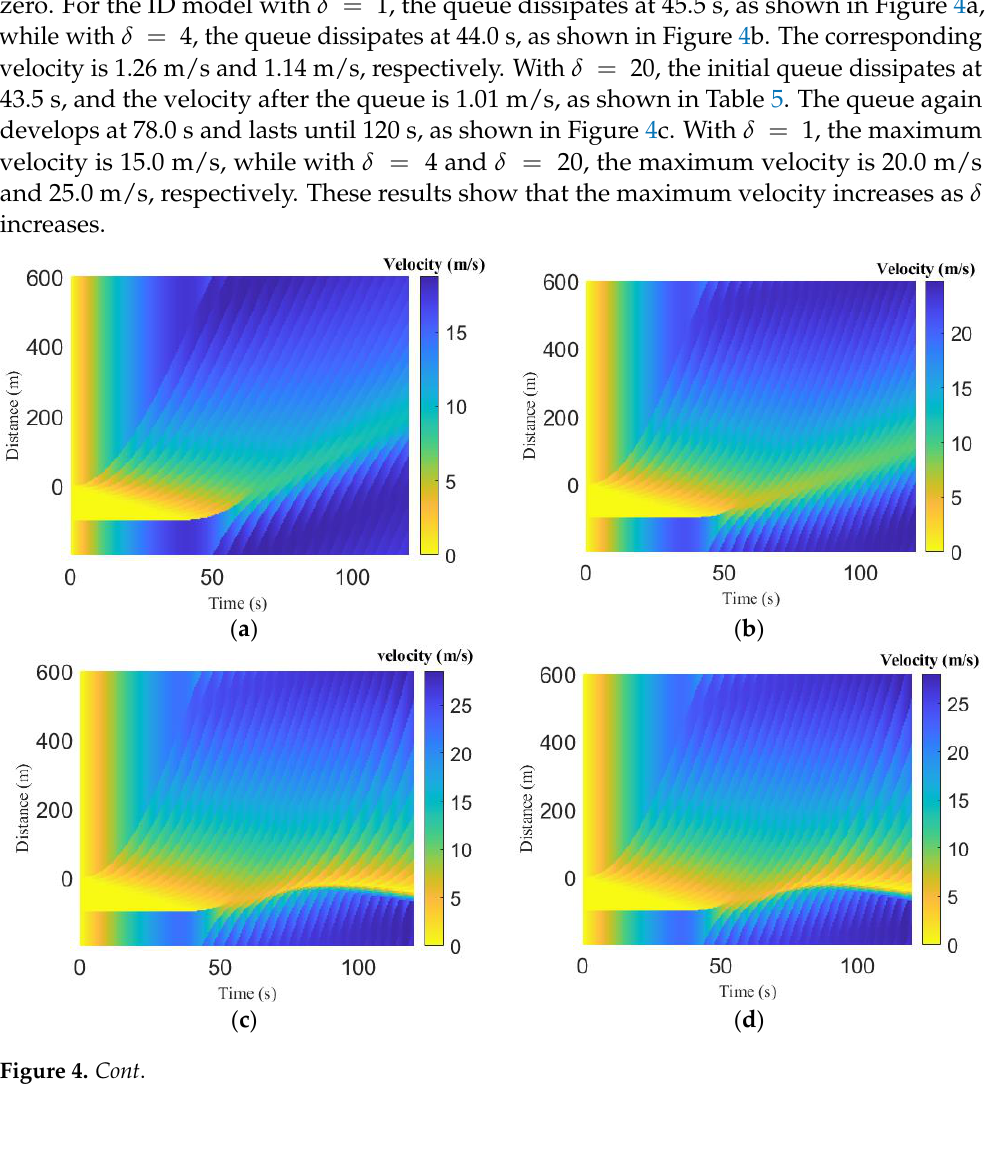
Table 3. Maximum flow and density, and critical velocity for the ID model.